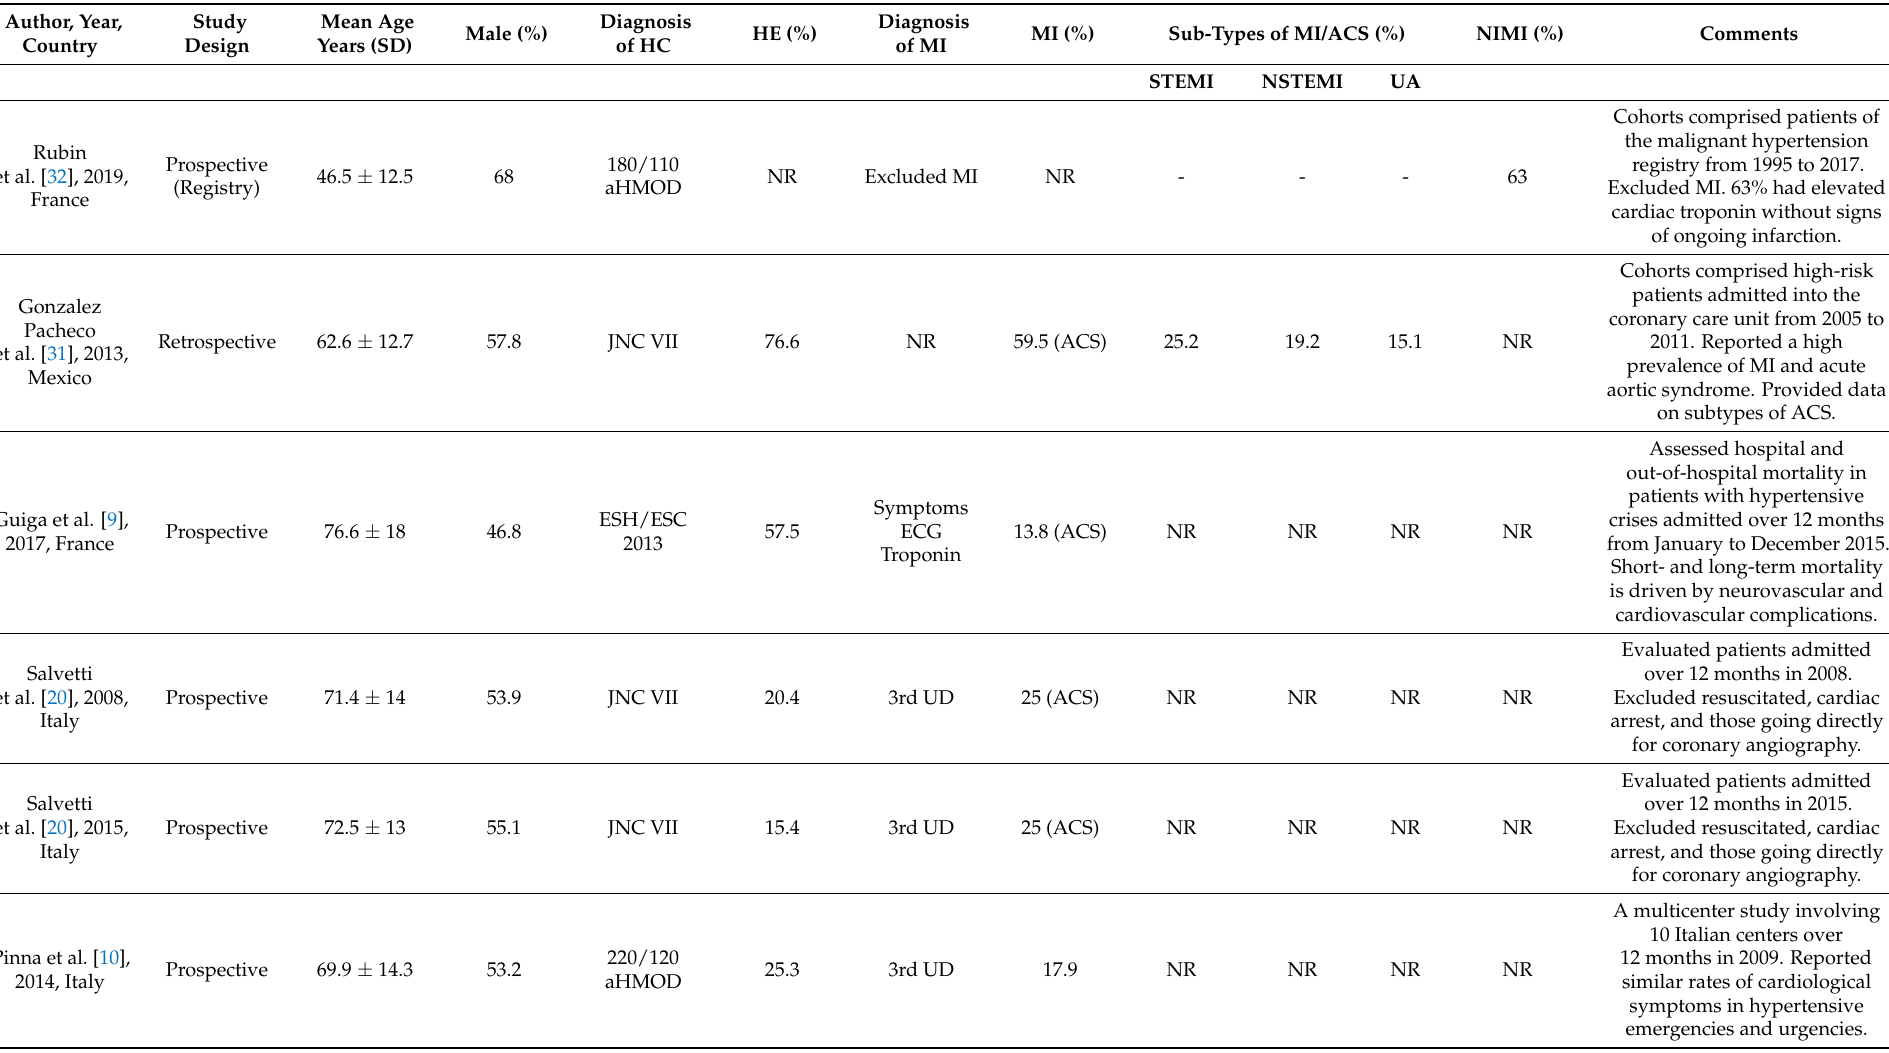
Table 1. Characteristics of studies included in the